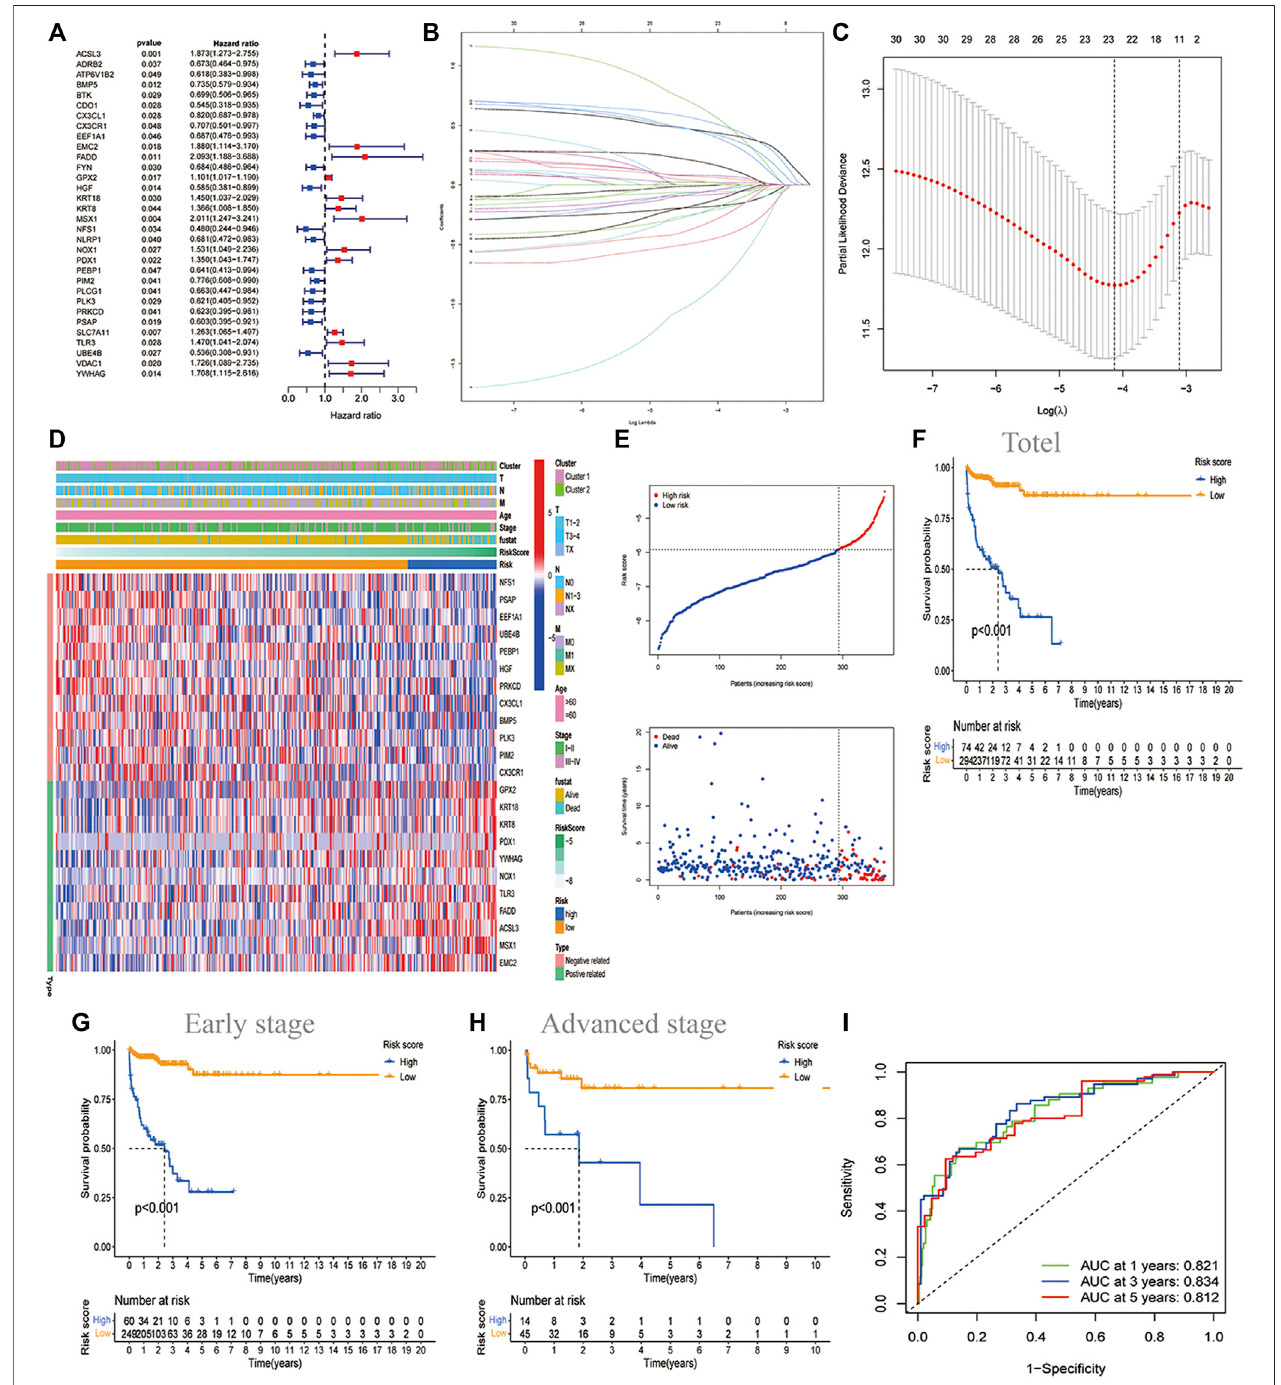
FIGURE 2 | Construction of the PCD-based signature in TCGA datasets. (A) The forest map showing the 32 prognostic PCD-related DEGs by univariate cox regression analysis ( p < 0.05). (B) Cross-validation for adjusting the parameter selection in the LASSO regression. (C) LASSO regression analysis of the 32 OS-related DEGs. (D) Heatmap showingthefeaturesof23identi fi edgenesandclinicalcharacteristics oftwomolecularclusters. (E) Thedistributionofriskscoreandsurvivalstates. KaplanMeierplotshowingthesigni fi cantdifferenceofOSintotalLUAD( n =368) (F) ;inearly-stage(IorII)(n=309) (G) andinadvancedstage(IIIorIV)(n=59) (H) in the high-risk and low-risk groups. (I) ROC curve showing the sensitivity and speci fi city to predict 1-, 3-, and 5-years survival based on PCD-based signature, with the area under curve being 0.8210.834, and 0.812, respectively.